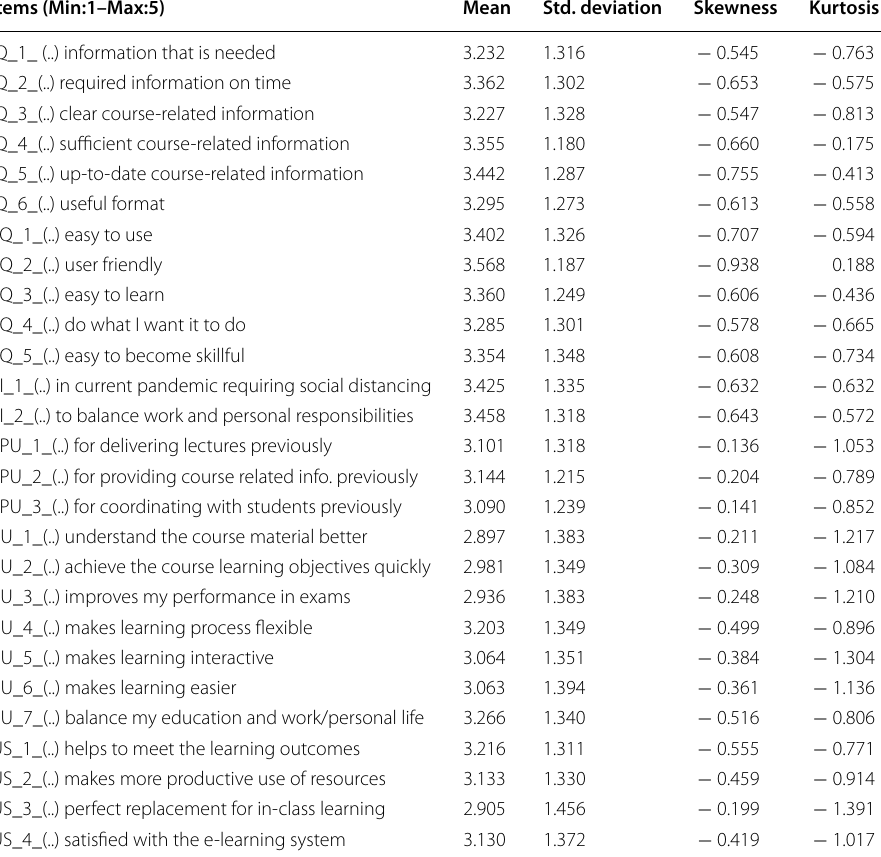
Table 4 Means, standard deviation, skewness and kurtosis Items (Min:1–Max:5) Mean Std. deviation Skewness Kurtosis IQ_1_ (..) information that is needed